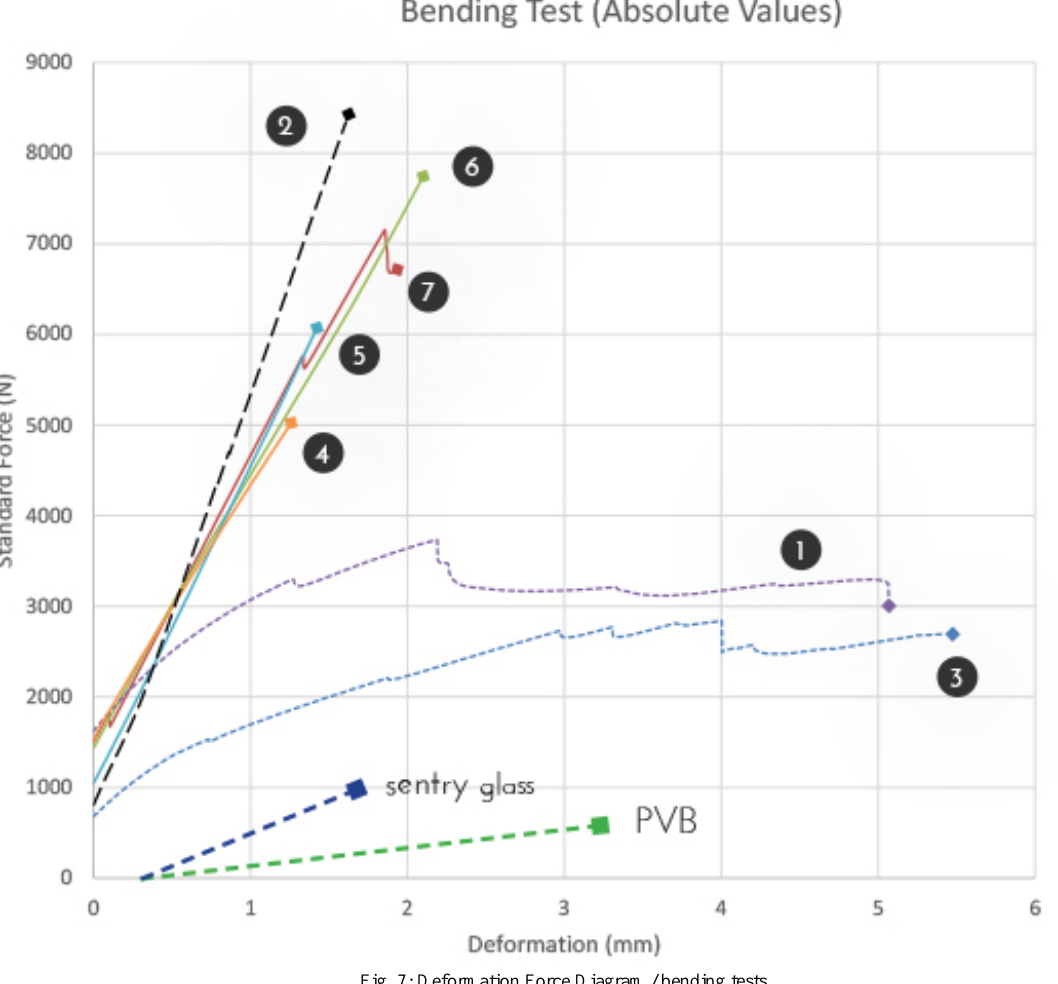
Fig. 7: Deformation Force Diagram / bending